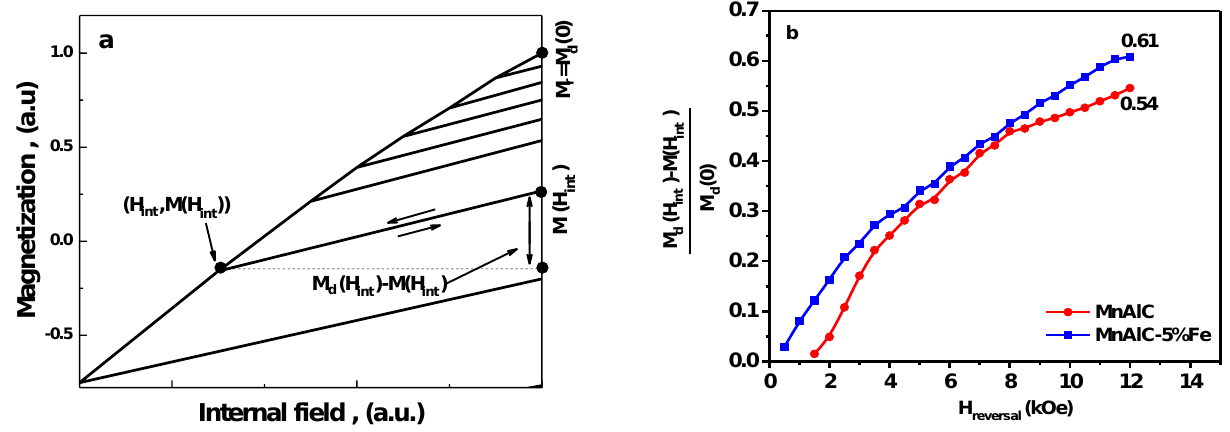
Figure 6. ( a ) Recoil curves showing critical parameters, and ( b ) comparison of reversible magnetization as a function of applied reversal field for Mn-Al-C and F5 samples.